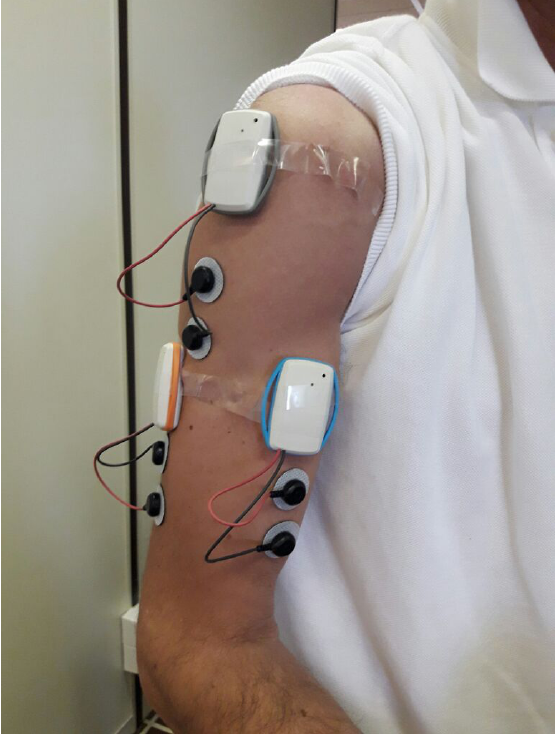
Figure 1. Recording setup. Photograph of the recording setup with the wireless electromyograph sensors worn on the upper right arm with their electrodes placed on the biceps brachii , deltoideus medius , and triceps brachii